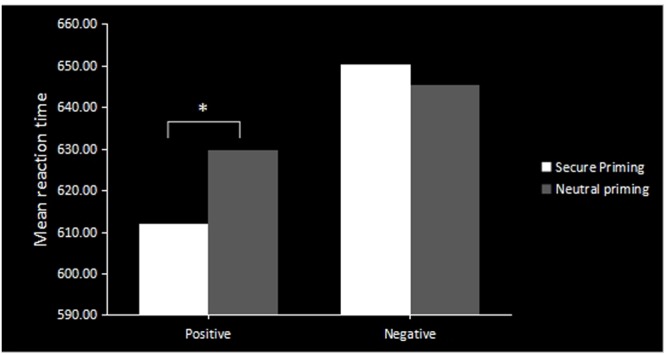
The behavioral result of emotional process suggested faster response-time to positive faces in secure priming than neutral priming. The asterisks (∗) indicate significant differences (∗p ≤ 0.05).